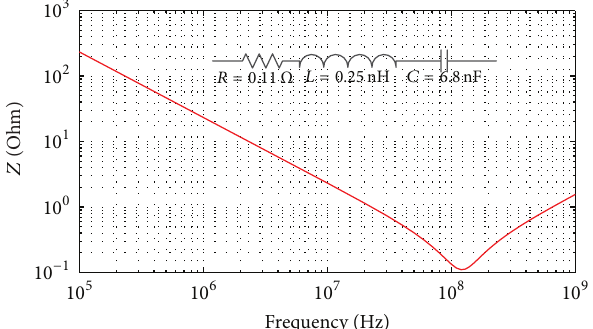
Figure 8: Impedance and equivalent circuit model of the DPI